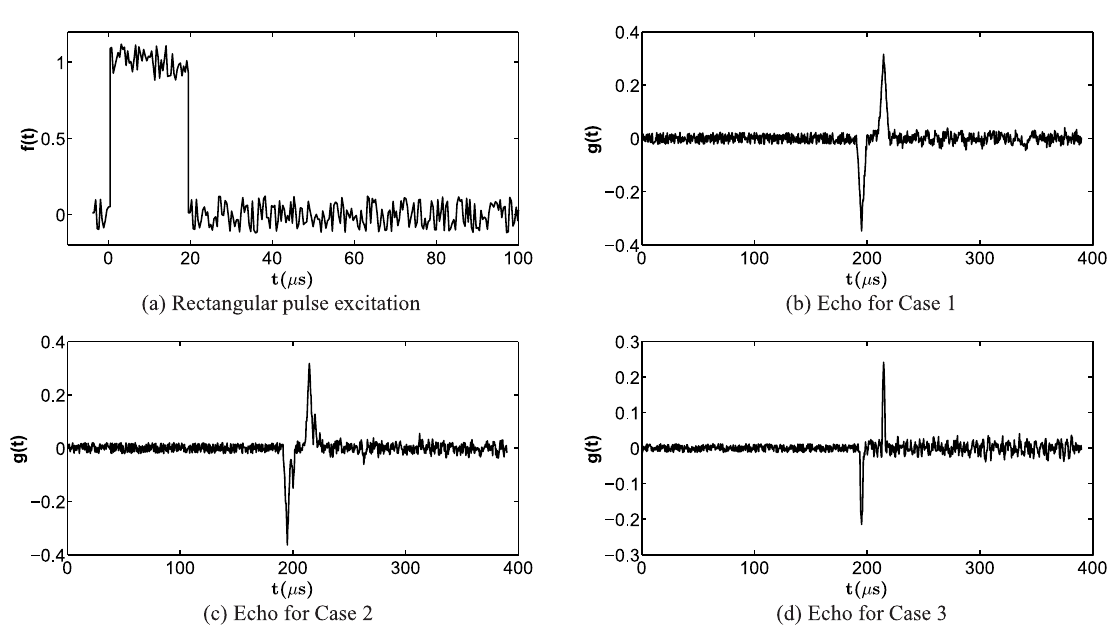
Fig. 4. Identification with noiseless data for Cases 1 to 3.